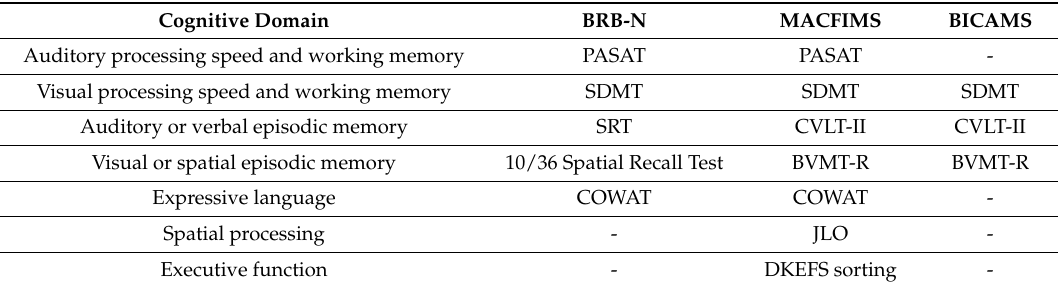
Table 2. Comparison of the three most used neuropsychological batteries in MS. Cognitive Domain BRB-N MACFIMS BICAMS Auditory processing speed and working memory PASAT PASAT - Visual processing speed and working memory SDMT SDMT SDMT Auditory or verbal episodic memory SRT CVLT-II CVLT-II Visual or spatial episodic memory 10/36 Spatial Recall Test BVMT-R BVMT-R Expressive language COWAT COWAT - Spatial